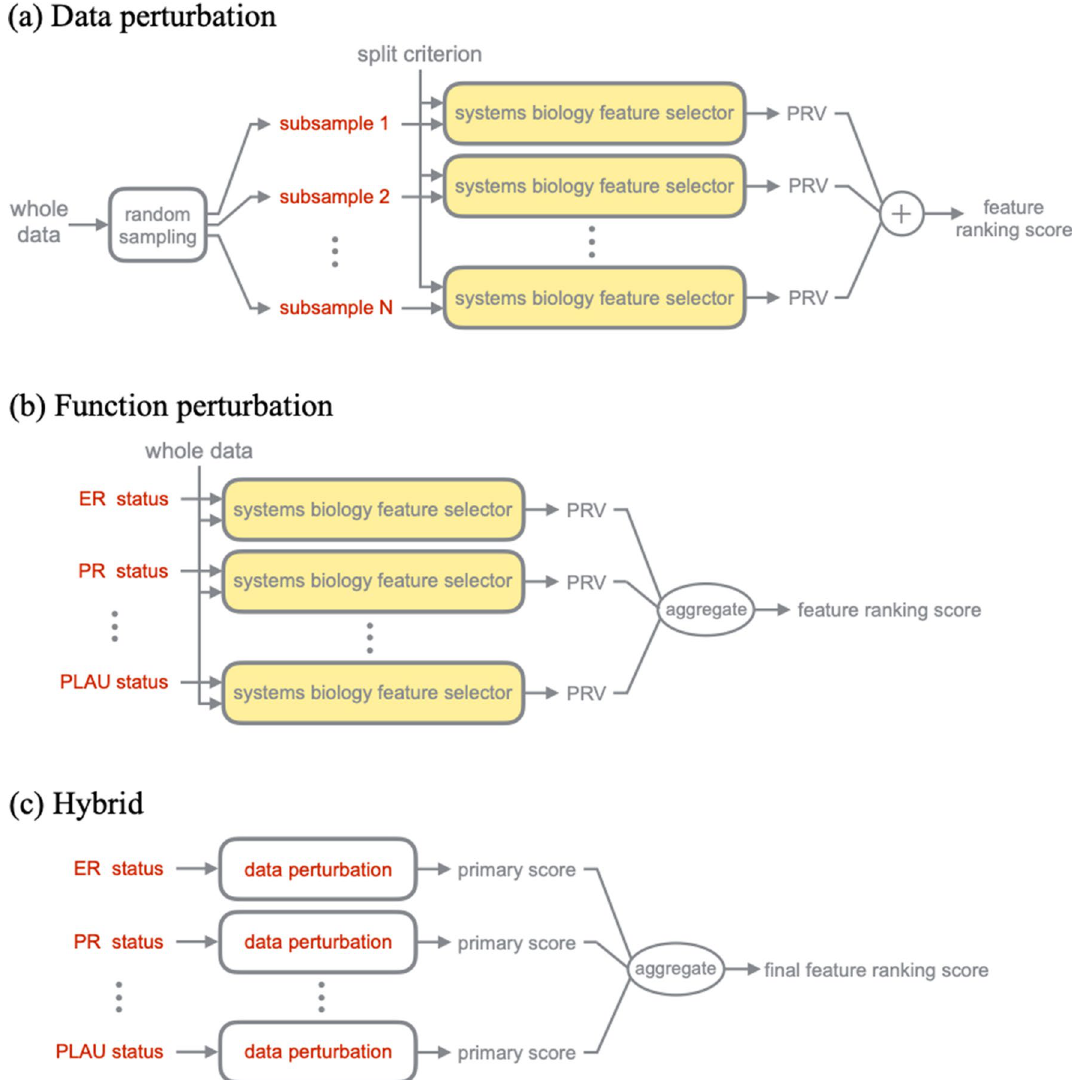
Figure 6. Ensemble feature selection workflow. ( a ) In data perturbation, multiple sample subsets were generated through random sampling. The systems biology feature selector was trained on different sample subsets. The output scores were then summed together to produce the final score. ( b ) In function perturbation, different systems biology feature selection functions were all trained on whole training data then aggregated to produce the final score. ( c ) In the hybrid ensemble approach, different systems biology feature selection functions first underwent data perturbation. Then the data perturbation output of different functions was aggregated to produce the final